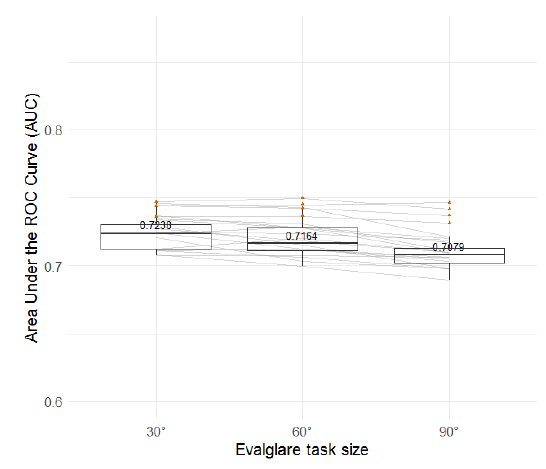
Figure 26. Boxplots of AUC for the three task area sizes (field study).